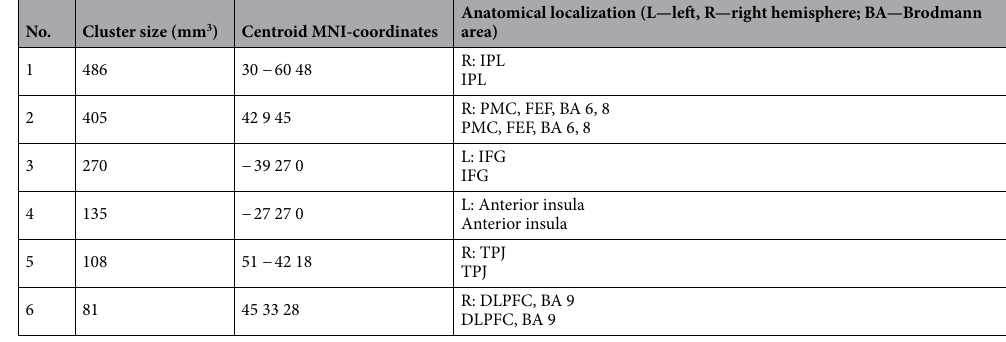
Table 2. Three-way overlap between the ALE meta-analysis and Bayesian analysis. IPL inferior parietal lobule, PMC premotor cortex, FEF frontal eye field, IFG inferior frontal gyrus, TPJ temporoparietal junction, DLPFC dorsolateral prefrontal